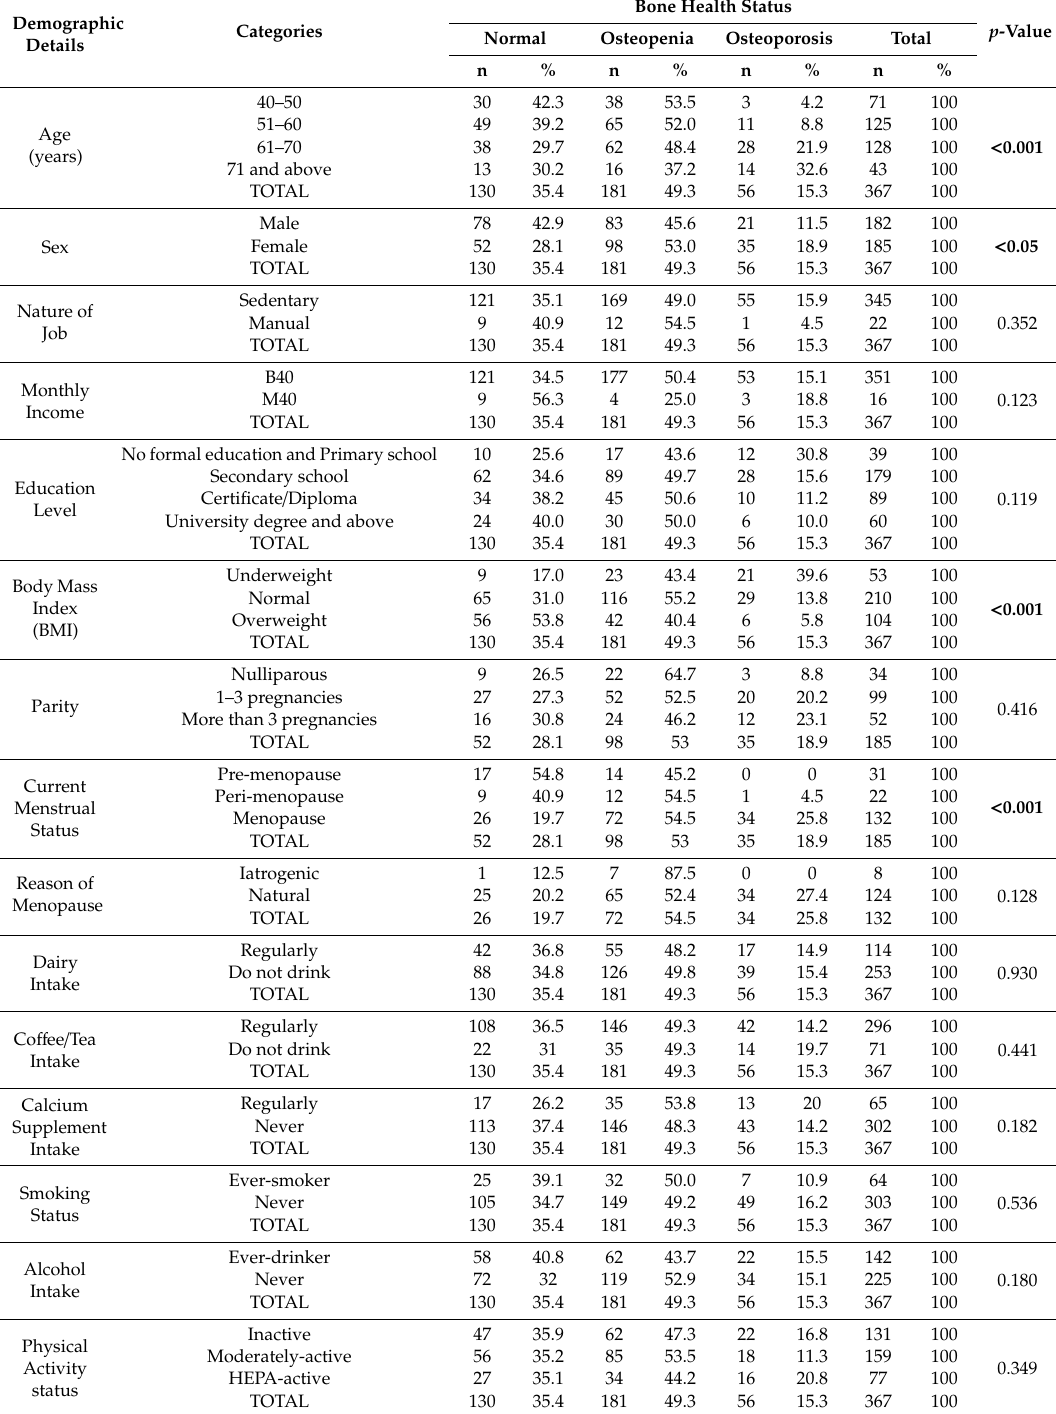
Table 3. Bone health status of the study population. HEPA, health-enhancing physical activity. The bolded p-values are statistically